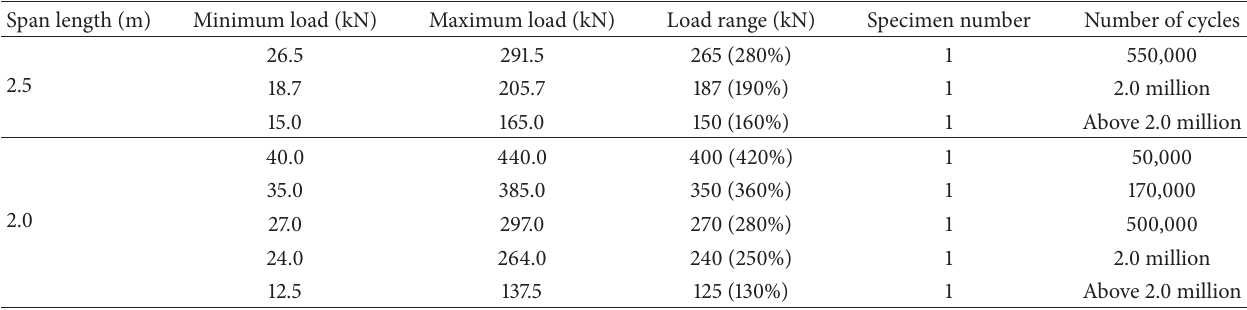
Table 2: Test specimen of the fatigue